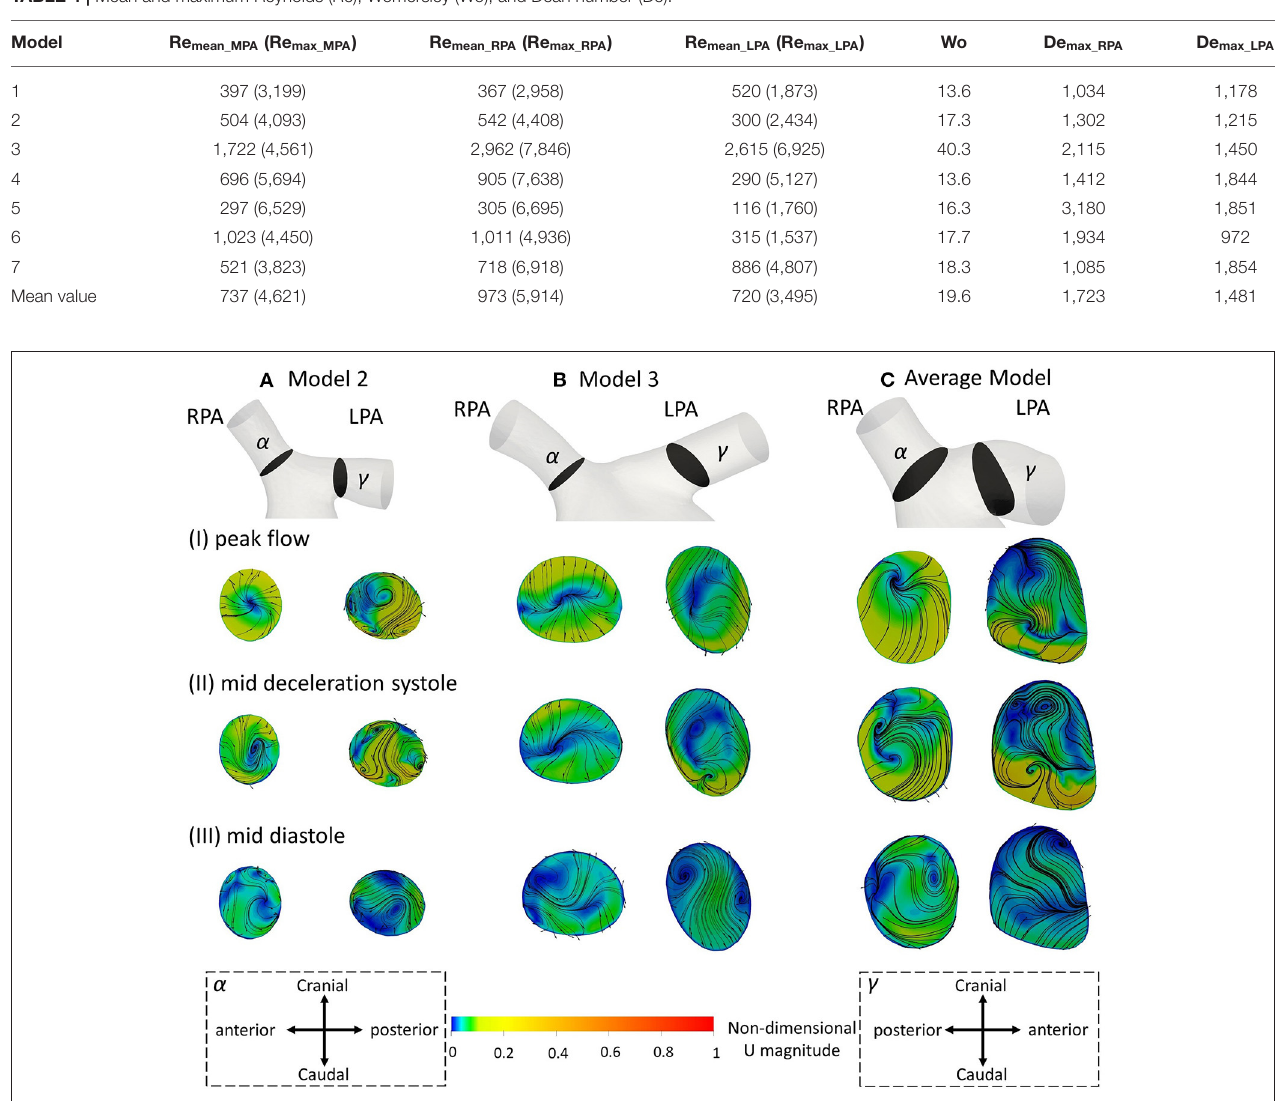
FIGURE 5 | Secondary flow visualized by in plane velocity vectors and contours of normalized velocity normal to the slice during (I) peak flow; (II) mid deceleration at systole; and (III) mid diastole, for (A) model 2; (B) model 3; and (C) the average model. Non-dimensionalization was performed by division with the maximum velocity of each patient during the cardiac cycle. Points where slices ( α ) and ( γ ) are taken are visible in Figure 1B . Cross-sections are oriented with the top and the bottom edges corresponding to the cranial and caudal positions, respectively and left and right to the anterior and posterior of the pulmonary artery, for the RPA, and to the posterior and anterior of the pulmonary artery, for the LPA, respectively. Cross-sections are in